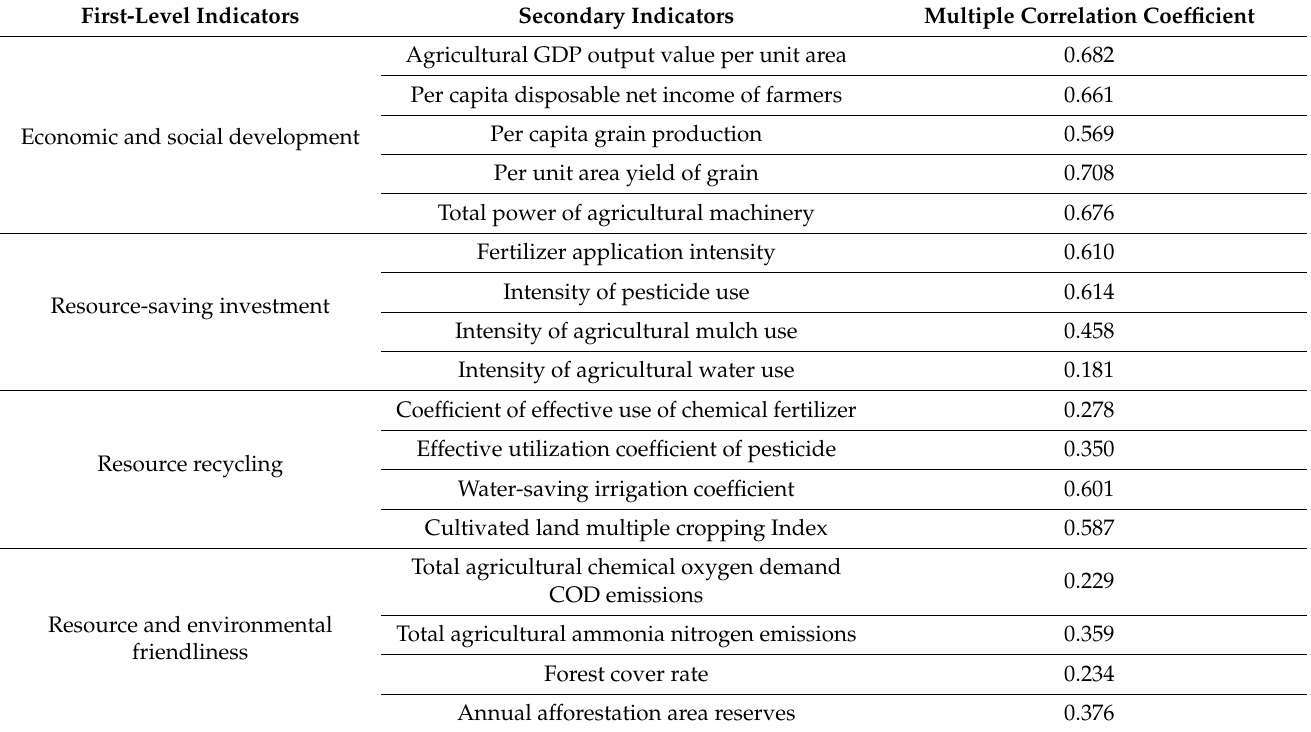
Table 3. The redundancy results of the index calculated by the “maximum uncorrelation